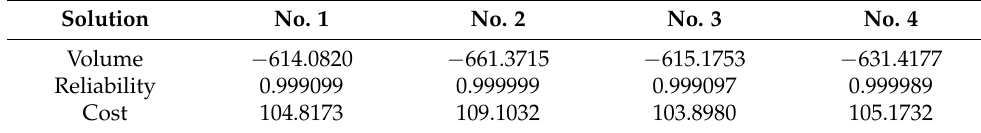
Figure 6. Pareto solution of the diesel engine reliability optimization design. Table 5. Partial Pareto solution set of the diesel engine optimization design.